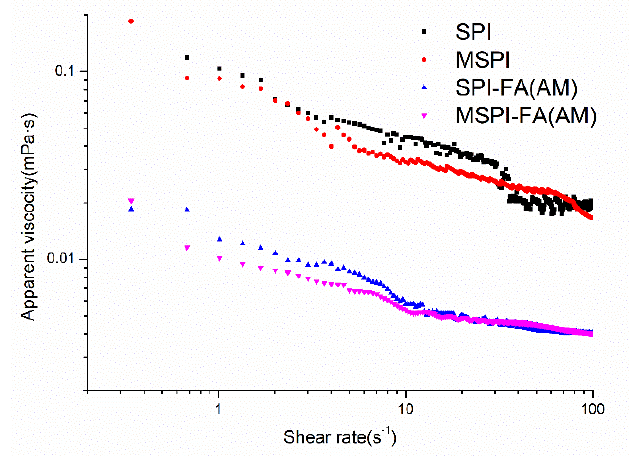
Figure 1. Rheology of emulsions: Apparent viscosity-shear rate flow curve of the emulsion, as the increased from 0.01 to 100 s − 1 . Table 2. The apparent viscosity ( η ), consistency index (K), and flow behavior index (n) of emulsions stabilized by different modified soybean protein isolates.